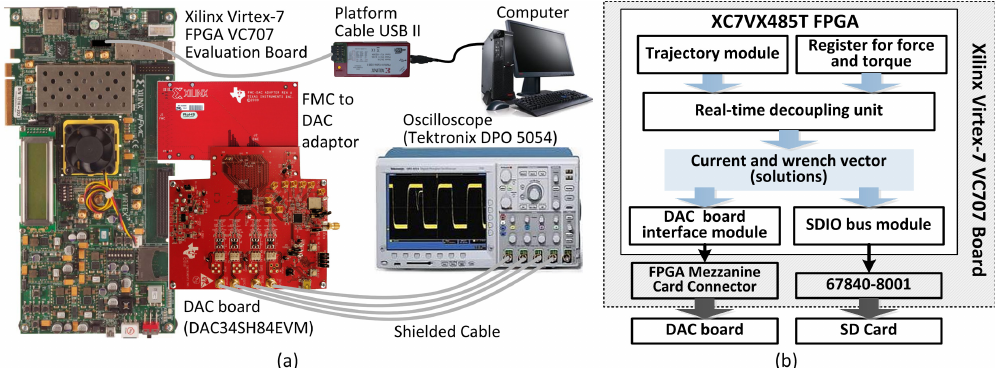
Figure 6. ( a ) Computation and displaying device for the implementation of numerical current decoupling for the magnetically levitated rotary actuator; ( b ) necessary computation modules in register-transfer level (RTL) structure and peripheral device for evaluation board. Table 2. Design parameters for the magnetically levitated rotary actuator shown in Figure 1.